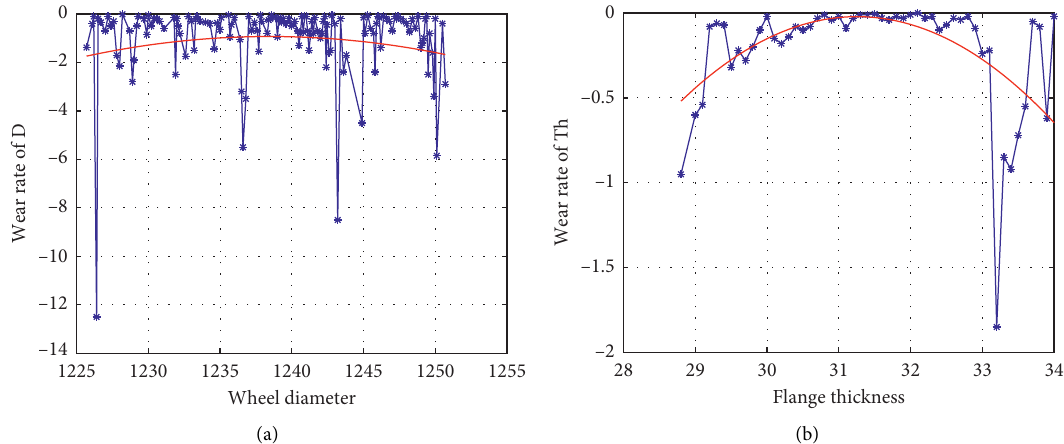
Figure 2: Fitted curves: (a) the wear rate of wheel diameter; (b) the wear rate of flange thickness.